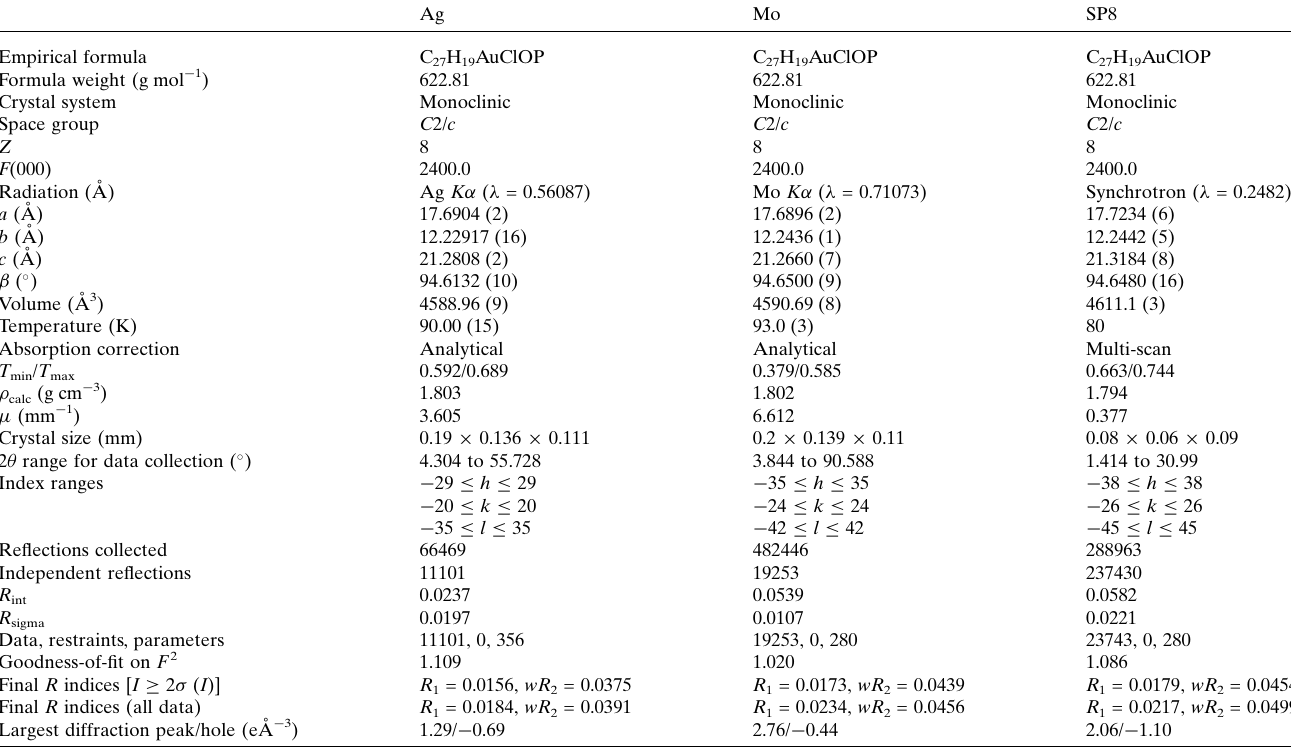
Table 1 X-ray data collection and structure refinement details of the Ag, Mo and SP8 datasets. Final R indices are provided for the IAM model refined in SHEXL (Sheldrick,